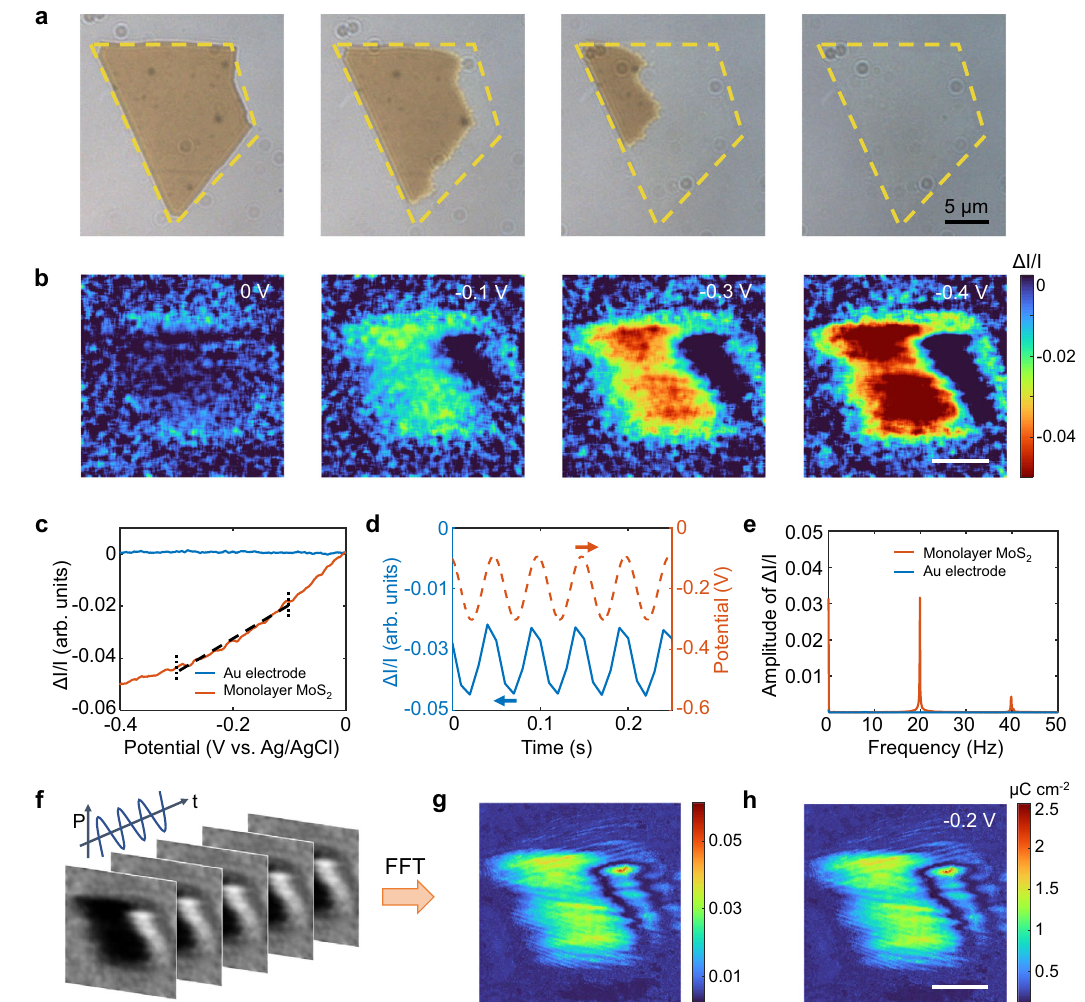
Fig. 2| Potentialmodulation ofthesurfacechargedensityofmonolayer MoS 2 . a Optical image of monolayer MoS 2 on a 1-octadecanethiol-modi fi ed gold fi lm. b Plasmonic images of monolayer MoS 2 at potentials of 0V, − 0.1V, − 0.3V and − 0.4Vin260mMphosphatebuffer(pH=6.86).Eachoftheimageswasobtainedby subtracting the fi rst image at 0V. Scale bar: 10 μ m. c Potential dependence of the plasmonic intensity change ( 4 I = I ) of monolayer MoS 2 and the gold fi lm. d Applied potentialmodulation(dashedline)andtheresultantplasmonicintensitychangeof